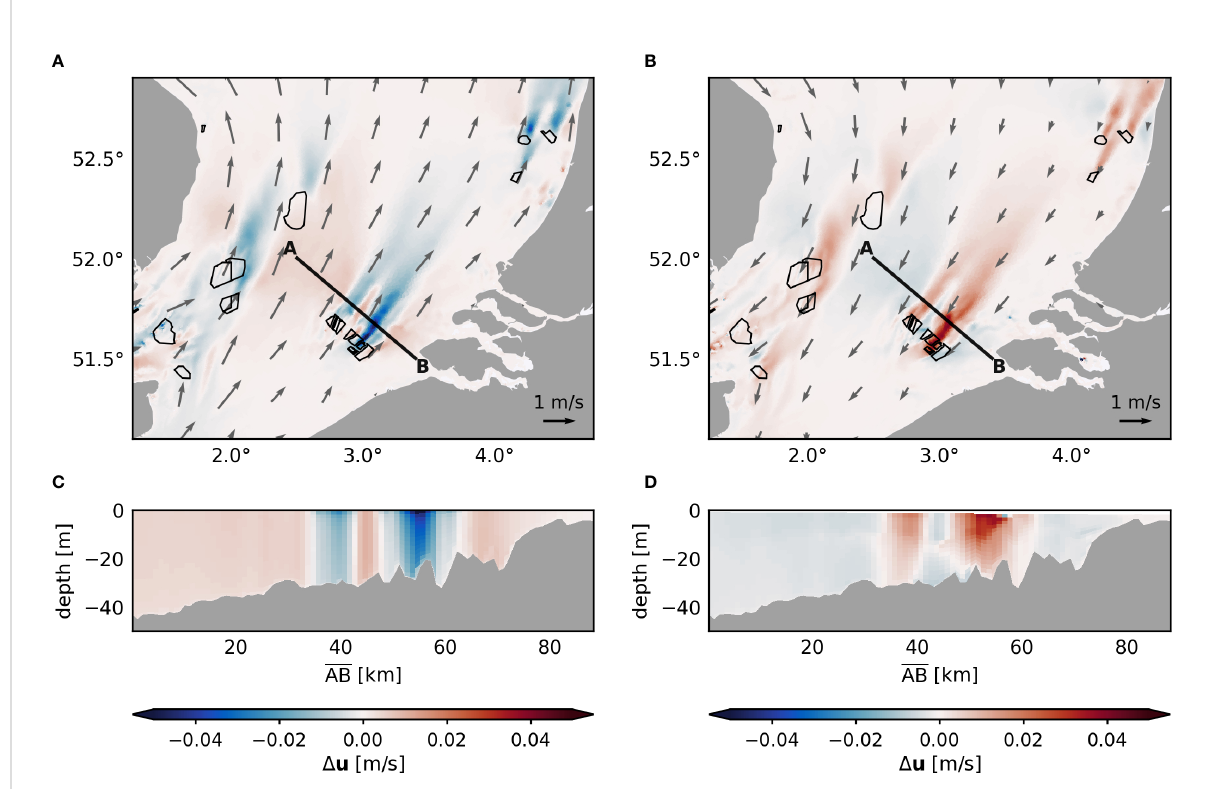
FIGURE 2 Horizontal velocity changes D u in the tidal scenario ( TIDES ) during fl ood tide (A, C) and ebb tide (B, D) . Flood and ebb tide examples correspond to May 10 at 03:00 and 09:00, respectively. Changes in horizontal velocity are shown for the surface layer (A, B) and with depth along the pro fi le AB (C, D). Gray arrows indicate the direction of the horizontal tidal fl ow. Black polygons indicate the offshore wind